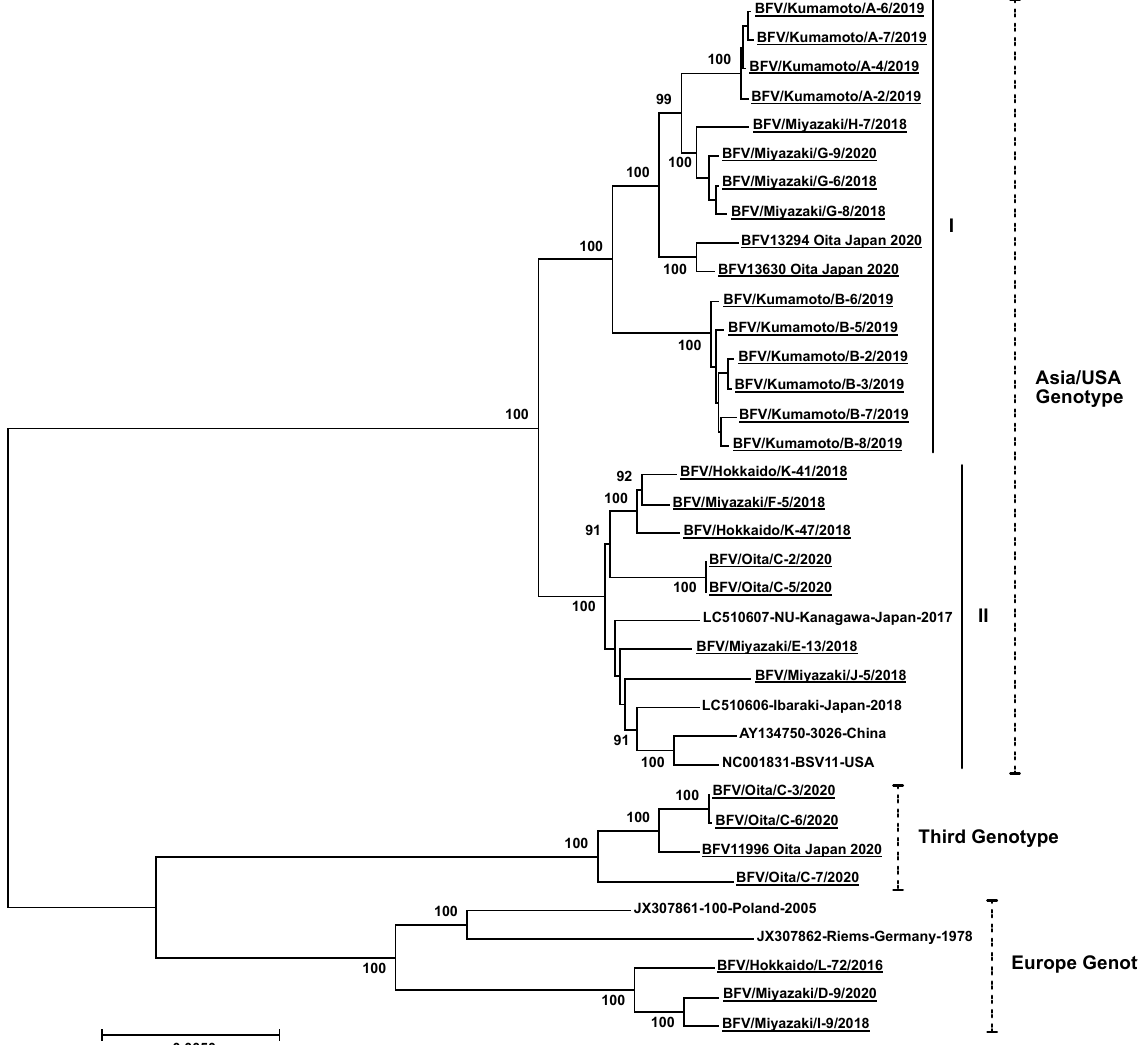
Figure 3. Phylogenetic analysis of the whole-genome sequences of bovine foamy virus (BFV). The analysis involved the whole-genome sequences of the 36 BFV isolates at the nucleotide level. The names of the 27 isolates for which the whole viral sequence was identified in this study are denoted as “BFV”, “isolation prefecture”, “name of isolate”, and “isolation year” separated by slashes and with underlines (e.g., BFV/Miyazaki/G-6/2018). Three isolates of the virus isolated in this study are named as “name of isolate”, “isolation prefecture”, “Japan”, and “isolation year” with underlines (e.g., BFV13294 Oita Japan 2020). The sequences retrieved from GenBank are denoted as “accession No.”, “name of strain”, “isolation (prefecture) country”, and “isolation year” separated by hyphens (e.g., LC150607-NU-Kanagawa-Japan-2017). Bootstrap values of more than 80% (1000 replicates) are shown next to the branches. The scale bar indicates the number of substitutions per site. The vertical broken and full bars show the classification of genotypes (Asia/USA, Third, and Europe) and clusters (I, II) of BFV, respectively.